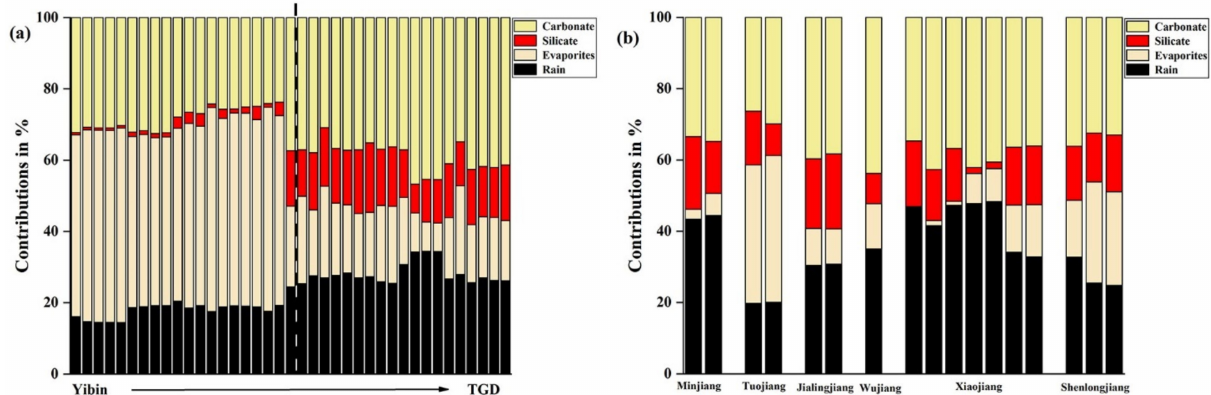
Figure 6. Different source ratios of cations in sampling sites. ( a ) Sources ratios of cations in the main channel; ( b ) the value of cations sources ratios in different tributaries. In the two pictures, the x-coordinate sample points are arranged in order from far to near distance from TGD.